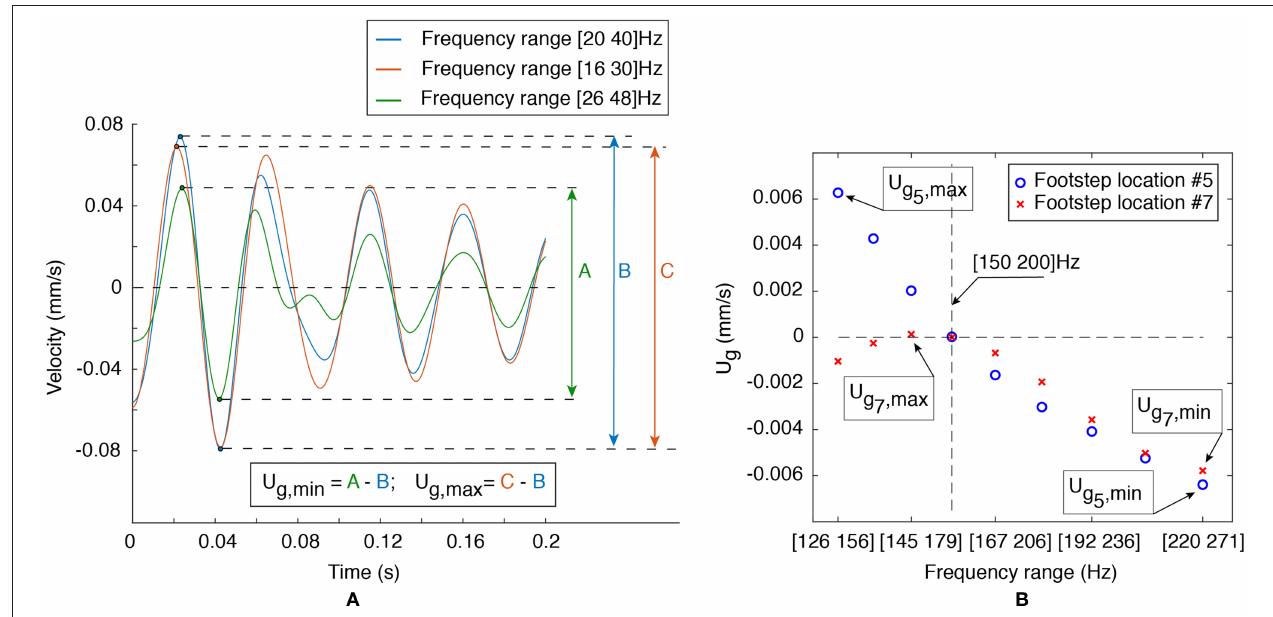
FIGURE 8 | Estimation of signal-decomposition uncertainty at low-and-high frequency components is explained. (A) Presents signal-decomposition uncertainty for low-frequency components for Sensor S1 of a footstep signal that is estimated by taking the difference between simulated 1 amp at frequency ranges {[16, 30] (C); [26, 48] (A)} Hz and components at frequency range [20, 40] Hz (B). (B) Presents signal decomposition uncertainty distributions for high-frequency components for Sensor S1 of footstep signals #5 and #7 (see Figure 4 ) that are estimated by taking the difference between simulated 1 amp at frequency ranges within [126–271] Hz and components at frequency range [150, 200]